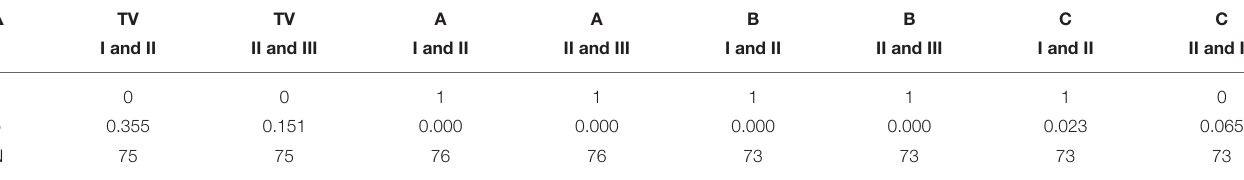
TABLE 1 | Testing for statistically significant changes in normalized SCL between adjacent regions during Cold1 (before treatment) and Cold2 (after treatment).